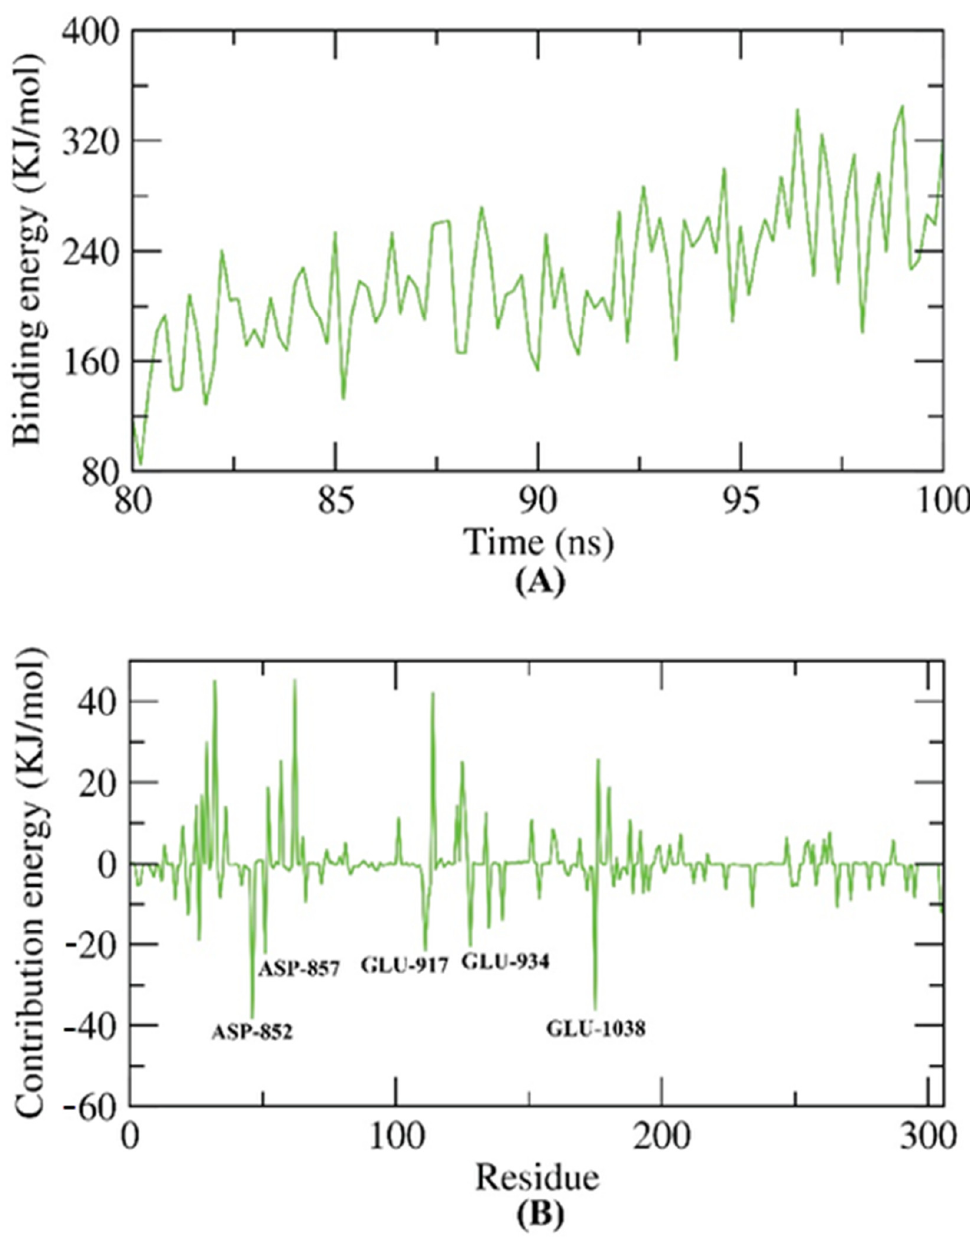
Figure 11. MM-PBSA results. ( A ) The exact binding energy of the VEGFR-2–compound 8 complex. ( B ) Amino acid residues that contributed in the binding process against VEGFR-2.